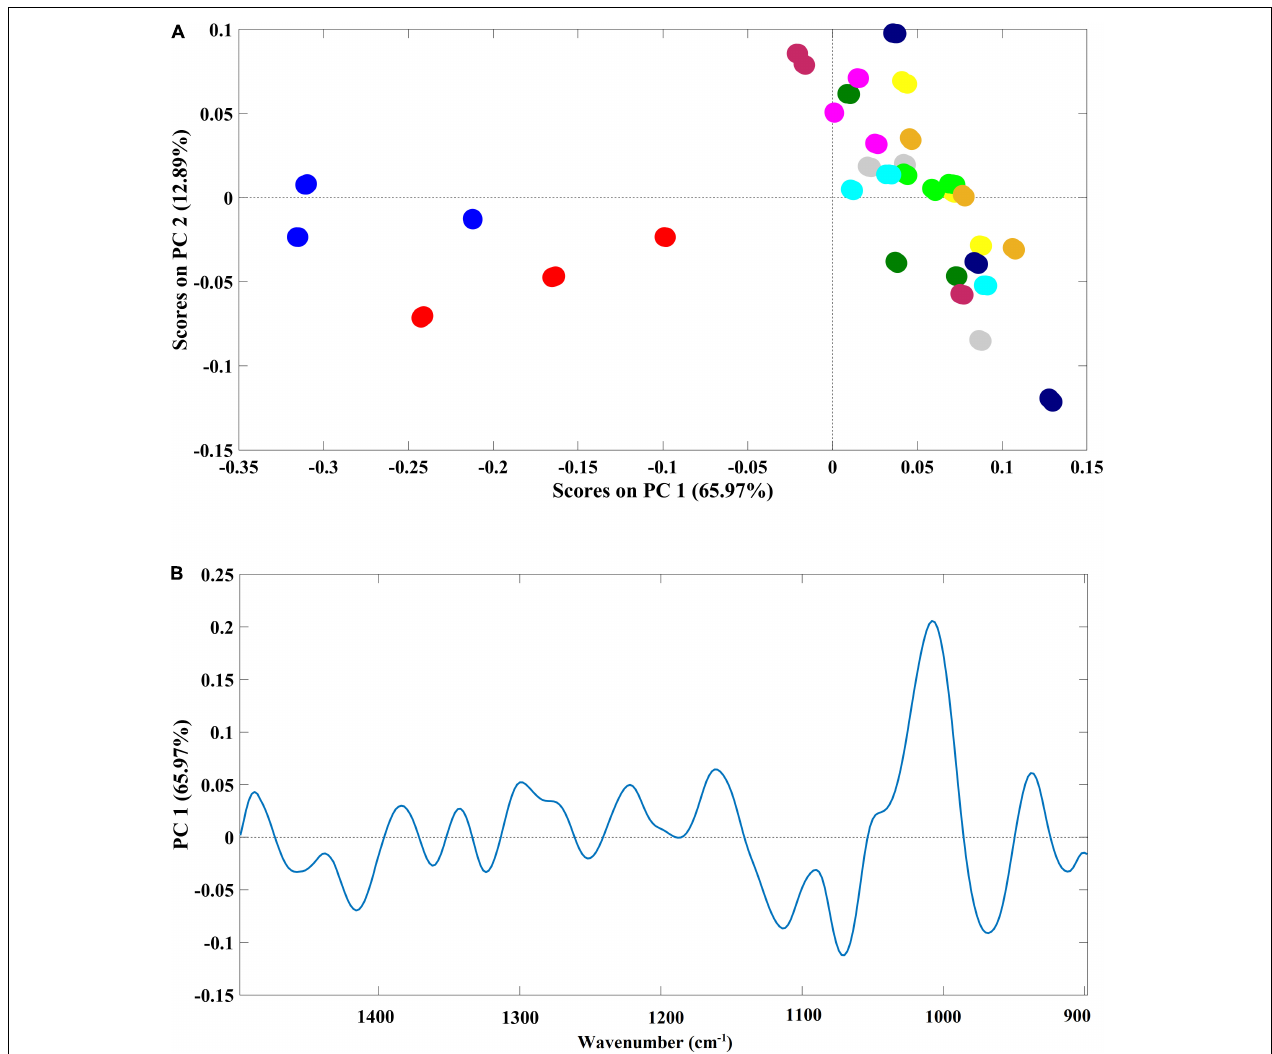
FIGURE 5 | (A) Principal component analysis (PCA) scatter plot based on PC1 and PC2 scores (better representing the separation between sample groups); and (B) loading plot of the PCA model, evidencing changes in the chemical composition of L. minor after the growth period in 11 different media. Samples were color-coded by growth medium: ultrapure water; Mars regolith extract; Steinberg medium; A. cylindrica filtered; A. cylindrica sonicated; N. muscorum filtered; N. muscorum sonicated; A. platensis filtered; A. platensis sonicated; C. vulgaris filtered; C. vulgaris